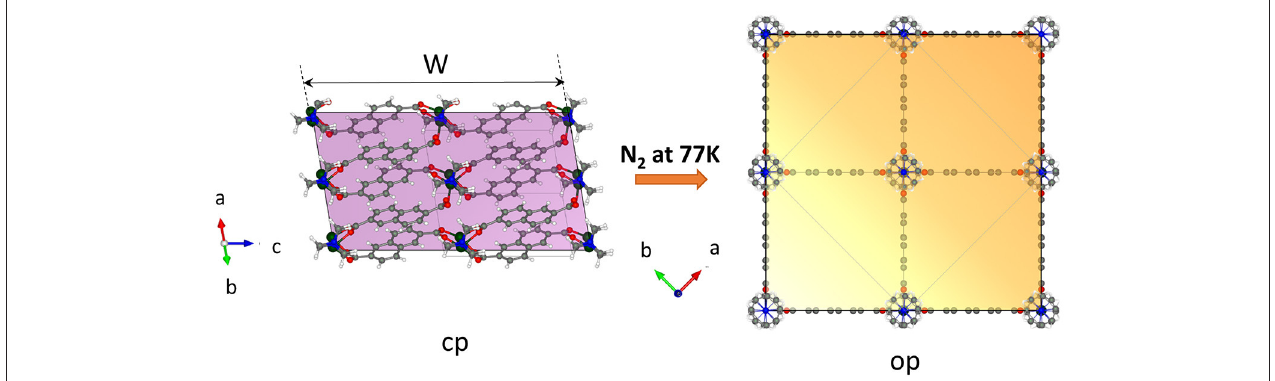
FIGURE 6 | View on the crystal in the cp and op phase along the pore channel (generated by the VESTA 3.5.5 software) (Momma and Izumi, 2011). The colored face is the face representing the entry of the channel-like pore structure.